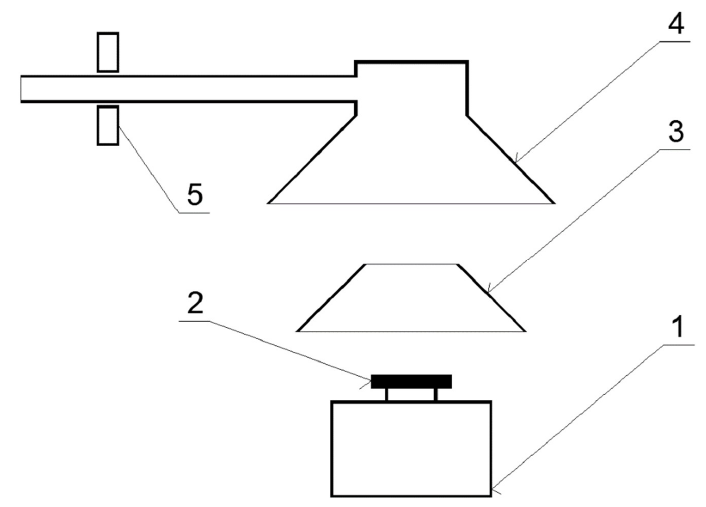
Figure 2. Basic scheme of cone calorimeter: ( 1 ) Scales, ( 2 ) Sample, ( 3 ) Cone heater, ( 4 ) Hood with exhaust duct, ( 5 ) Extinction area of smoke measuring device.